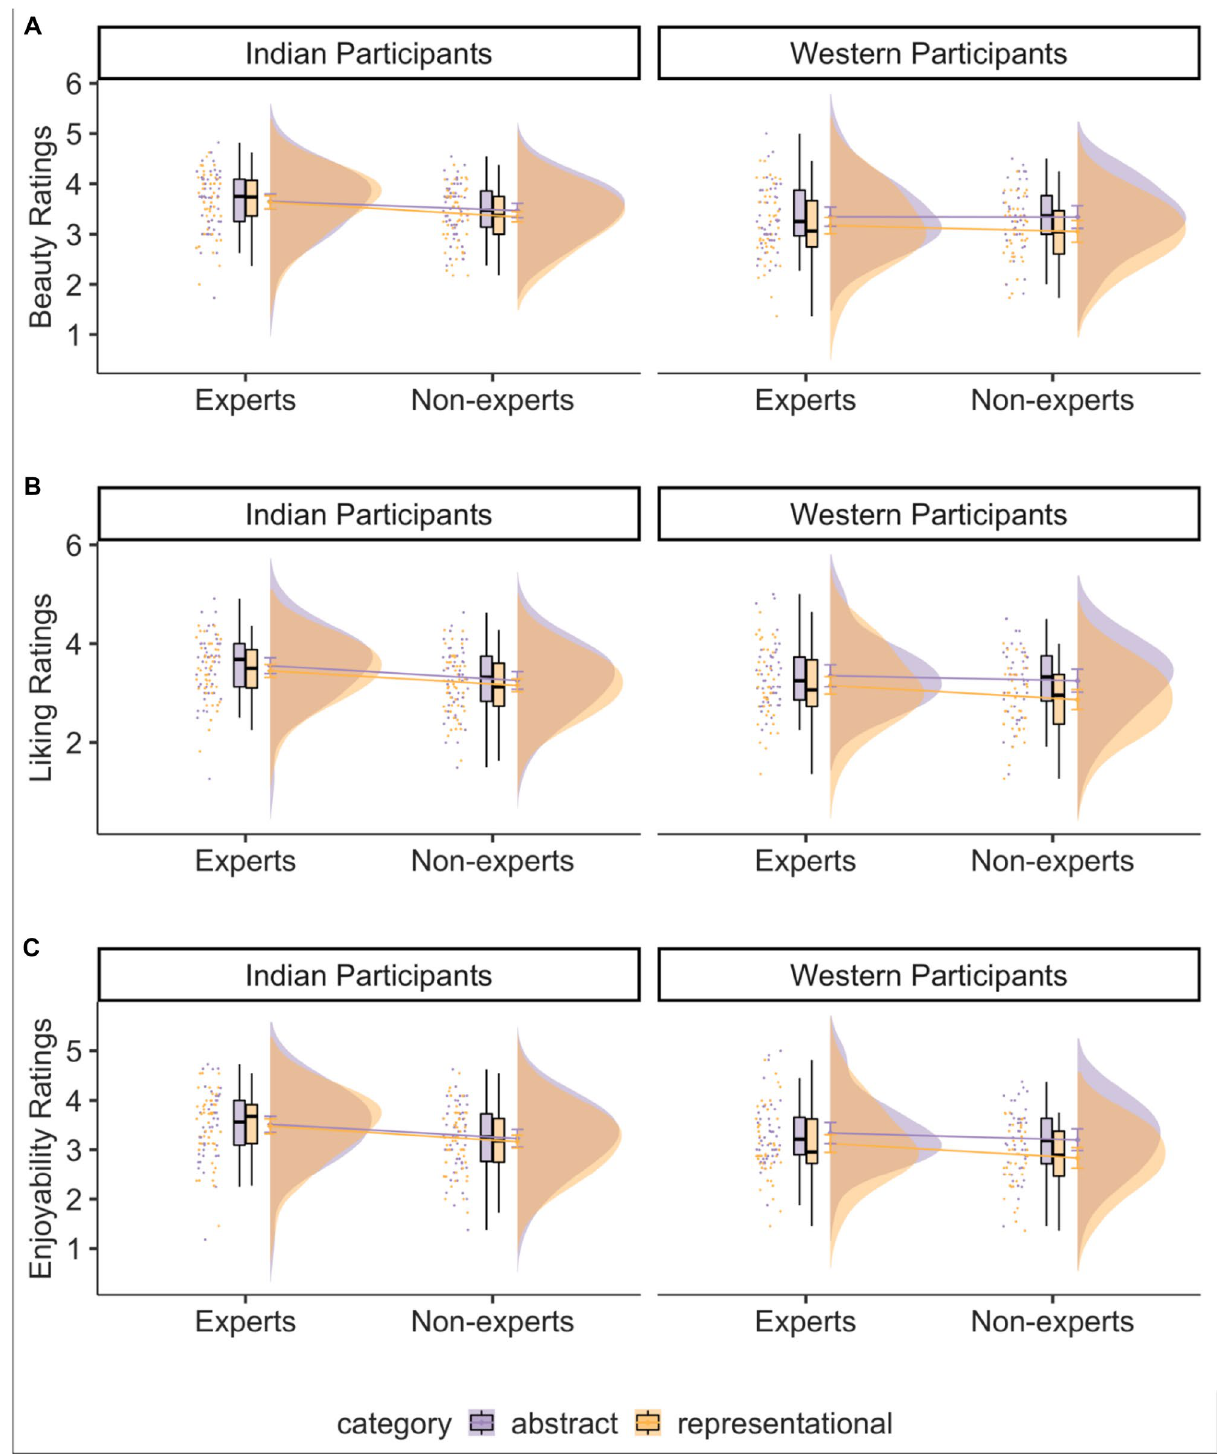
Figure 10. The effect of dance expertise (experts or non-experts) and culture (Indian or Western participants) on beauty, liking, and enjoyability ratings of abstract (in purple) and representational (in yellow) dance